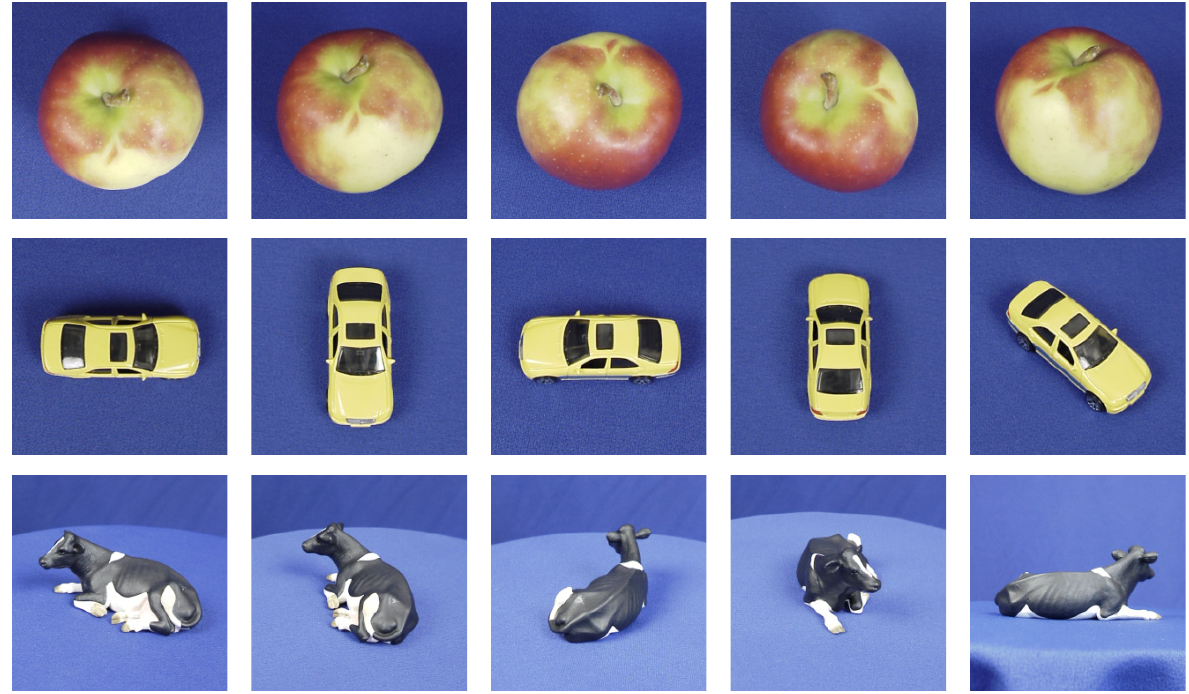
Figure 1. Some views of the model datasets on ETH-80 (one model per